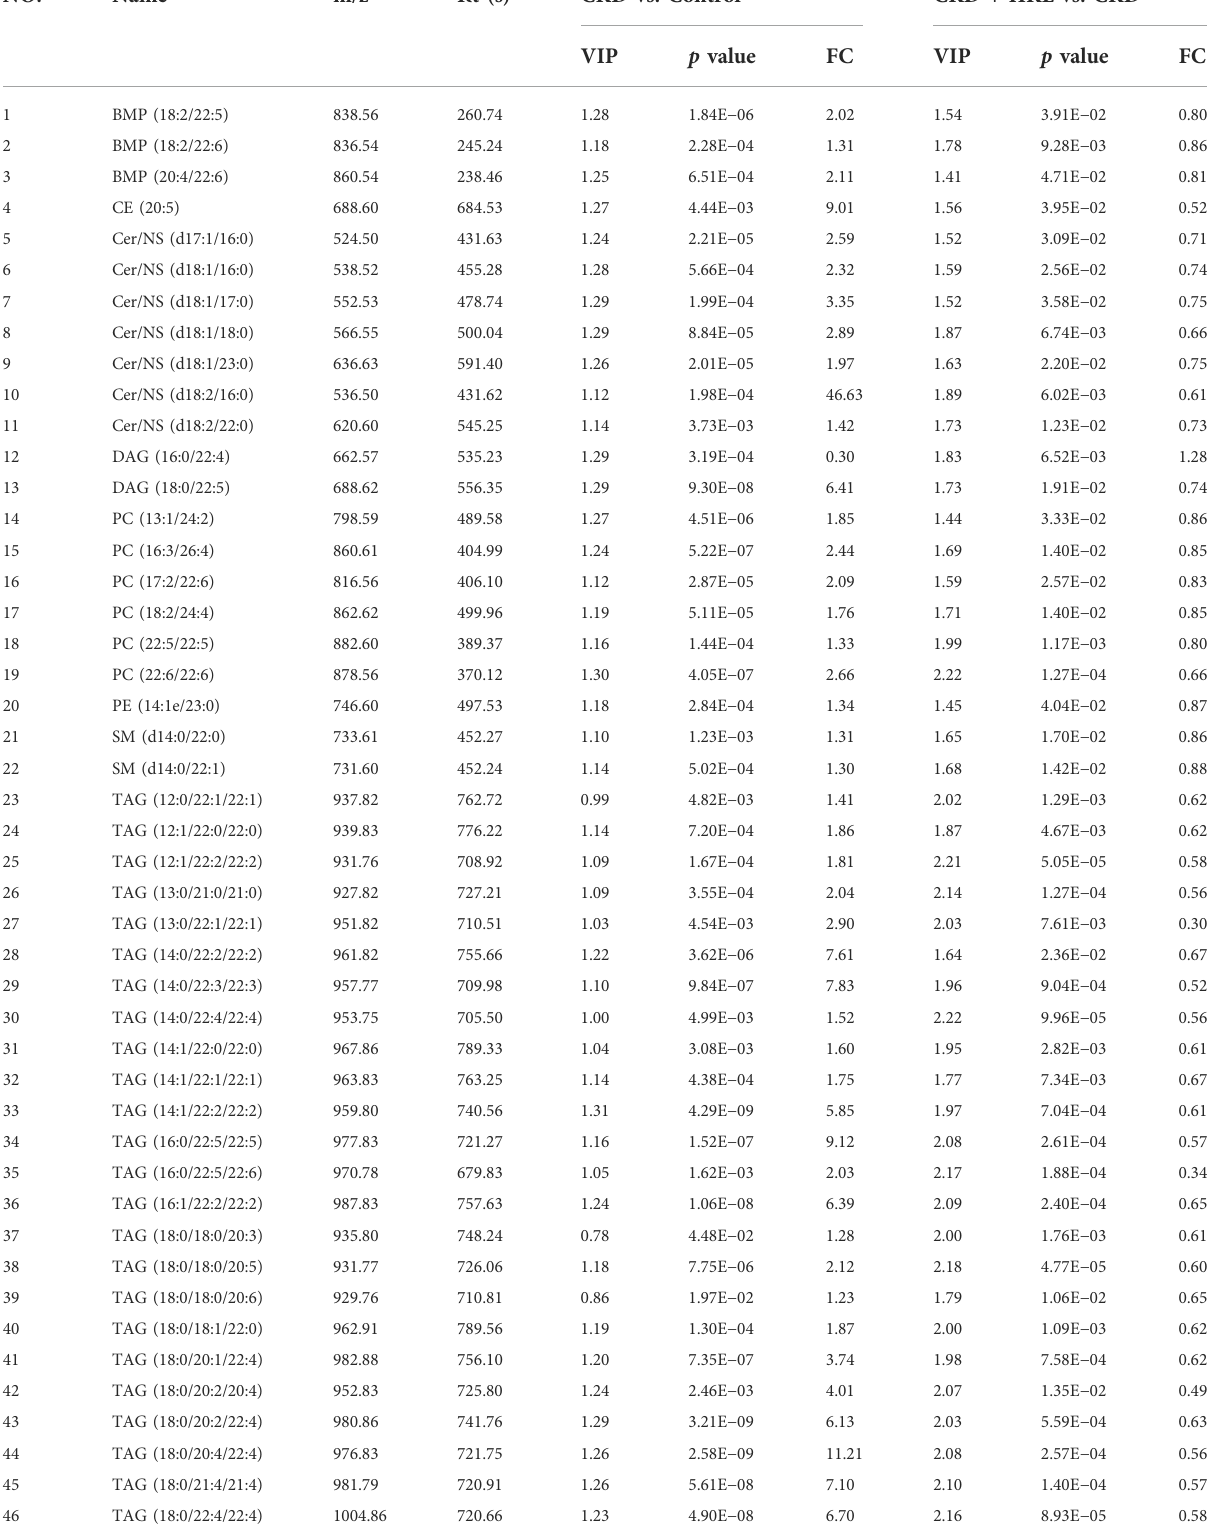
TABLE 2 The information of 66 identi fi ed lipids reversed by HKL treatment in positive ion mode.